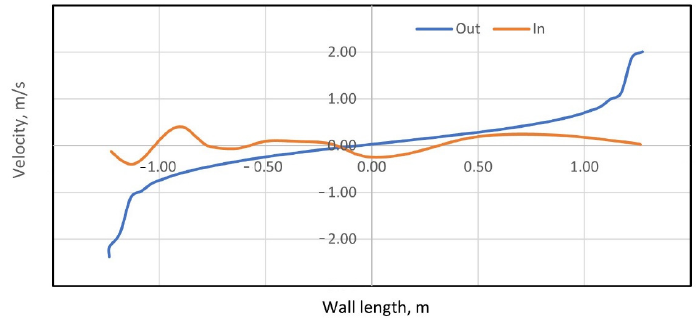
Figure 18. Velocities along the right wall.